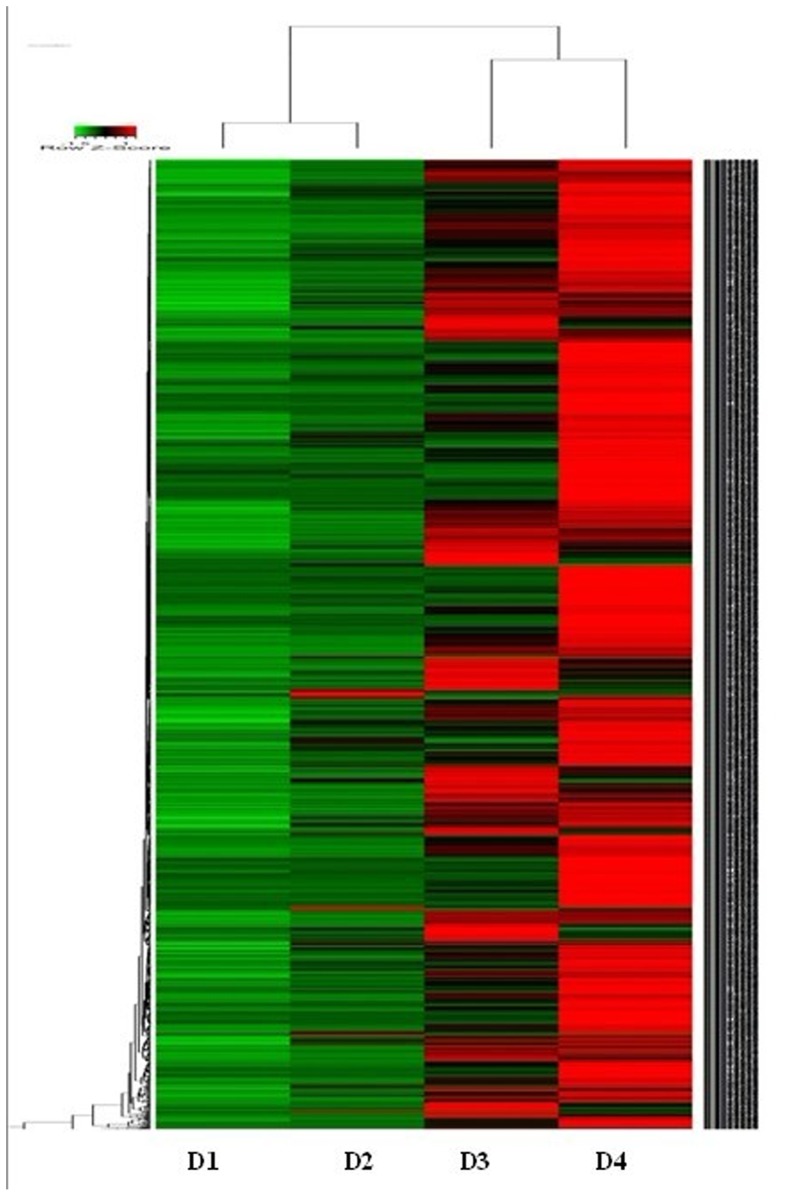
Heat map of the leaf transcriptome of Citrullus colocynthis depicting changes in transcript patterns of 2545 gene transcript clusters under water deficit treatment.Heatmap was produced using R. Each red or green block represents normalized expression value of a gene detected at 0 (D1), 24 (D2), 36 (D3) and 48 (D4) hours of withholding water. Red indicates higher gene expression values across treatment, while green indicates lower expression values across treatment.